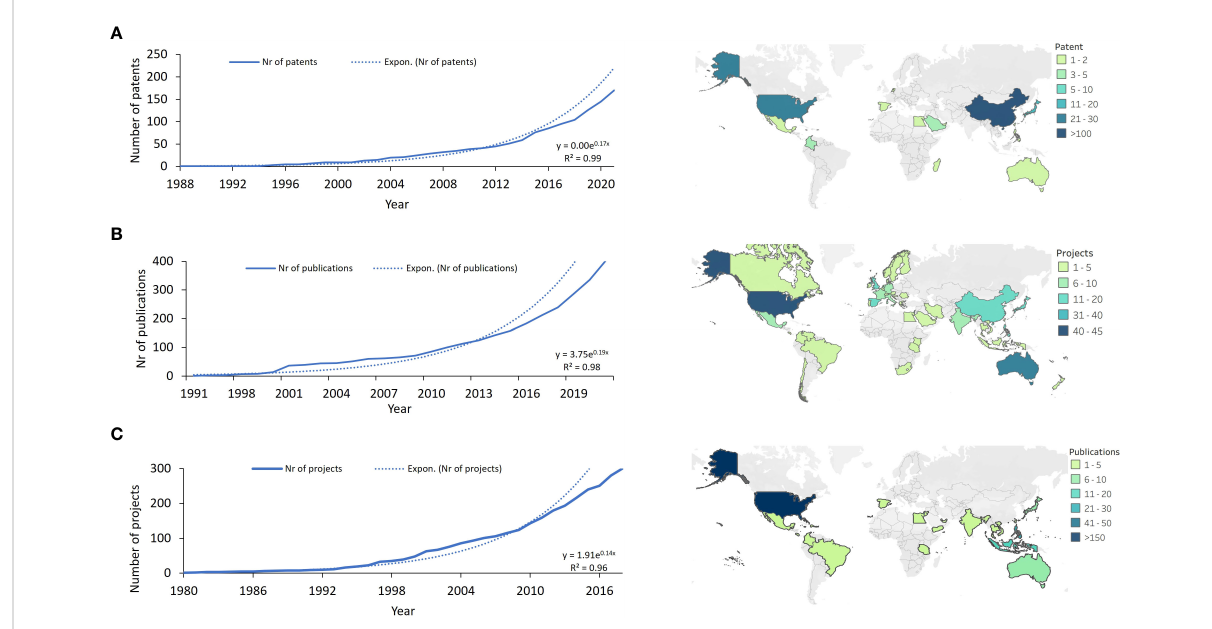
FIGURE 1 Left panel: growth trends, right panel: geographic distribution of (A) patent applications, (B) scienti fi c publications, and (C) restoration